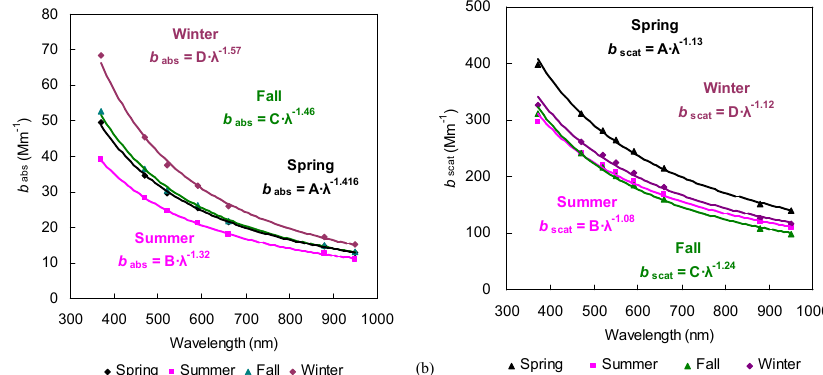
Fig. 6. Seasonal variations of (a) light absorption ( b abs ) and (b) light scattering coefficient ( b scat ) as a function of